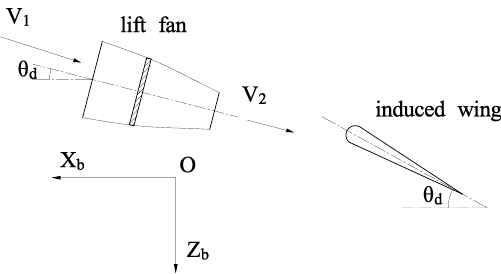
Figure 7. The geometrical relation between lift duct and induced duct.